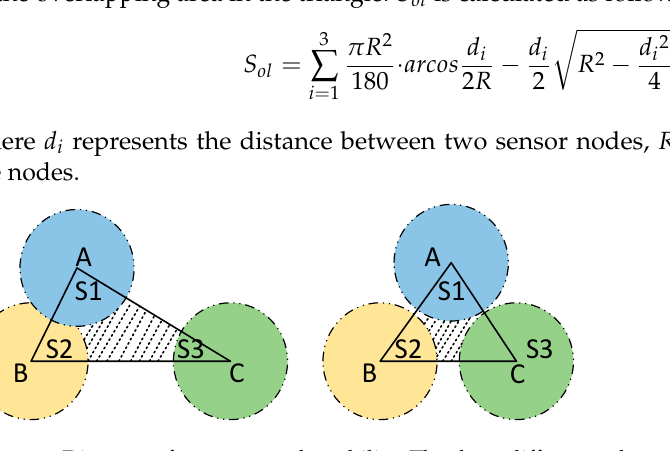
Figure 2. Diagram of coverage vulnerability. The three di ff erent colors represent the sensing areas of di ff erent nodes. different